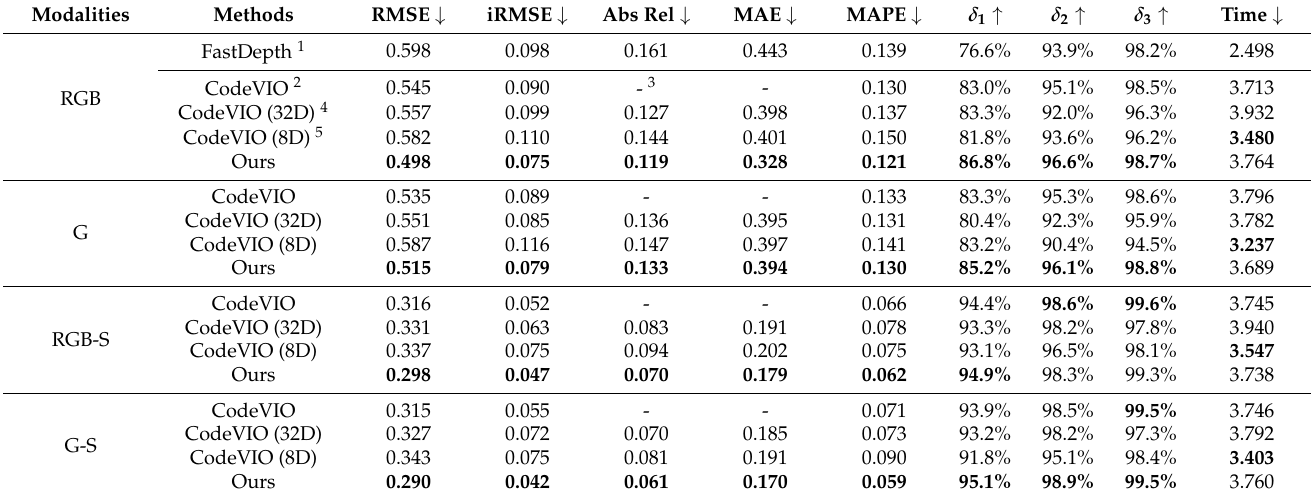
Table 1. Depth evaluation of typical light-weight depth estimation methods and our proposed network with different modalities (RGB (RGB), Gray (G), RGB + Sparse Depth (RGB-S), and Gray + Sparse Depth (G-S)) on the NYU Depth V2 dataset. The best is shown in